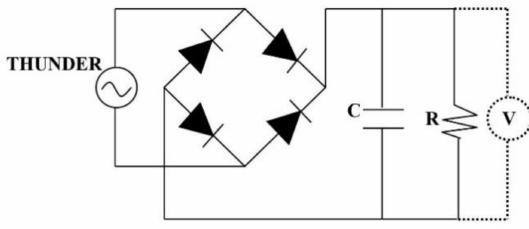
Figure 8. Energy harvesting circuit. Table 4. Summary of the experimental setup.